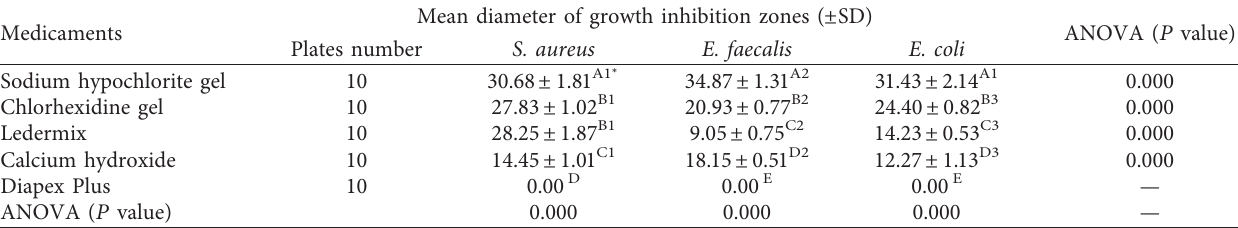
Table 3: Comparisons of mean diameters of inhibition zones (mm) formed by the tested medicaments against each bacterial strain. Medicaments